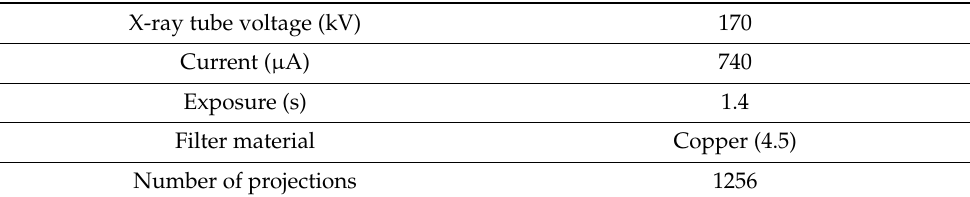
Figure 12. Region of volume KH-09-09 reconstructed: ( a ) FBP of high-dose projections; ( b ) FBP of denoised projection by CNN architecture of Figure 10; ( c ) FBP of noisy projections; and ( d ) MLEM of noisy projections. Table 2. CT scan parameters for the object